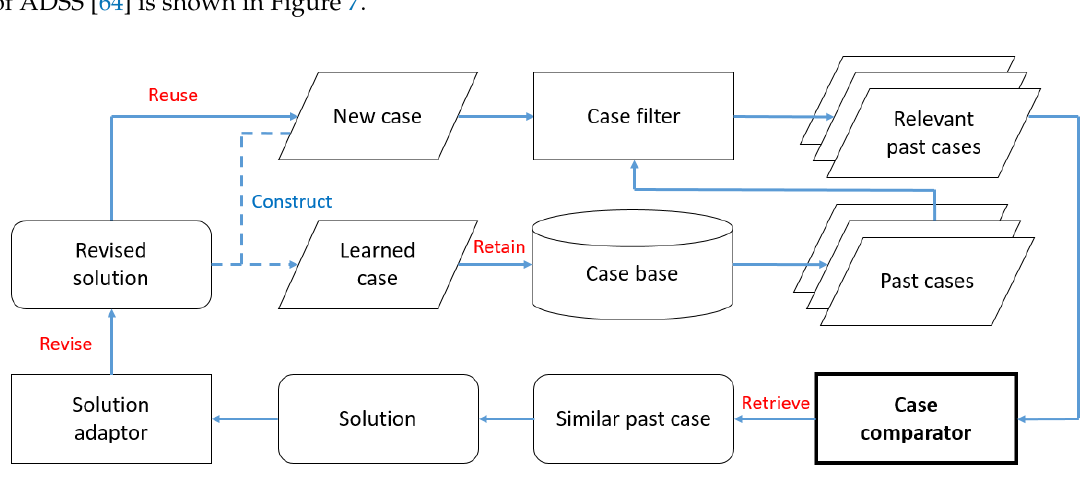
Figure 6. An example of the pair representation in an agricultural decision support system (ADSS).